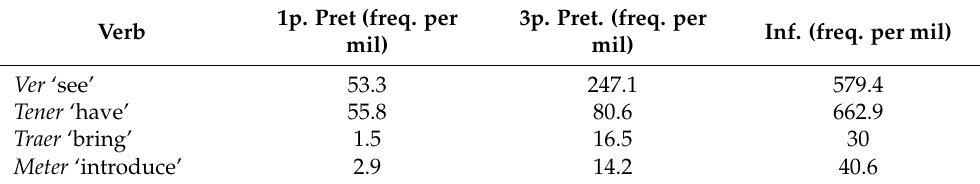
Table 3. Average relative frequencies by person and verb (CREA, NOW and WEB